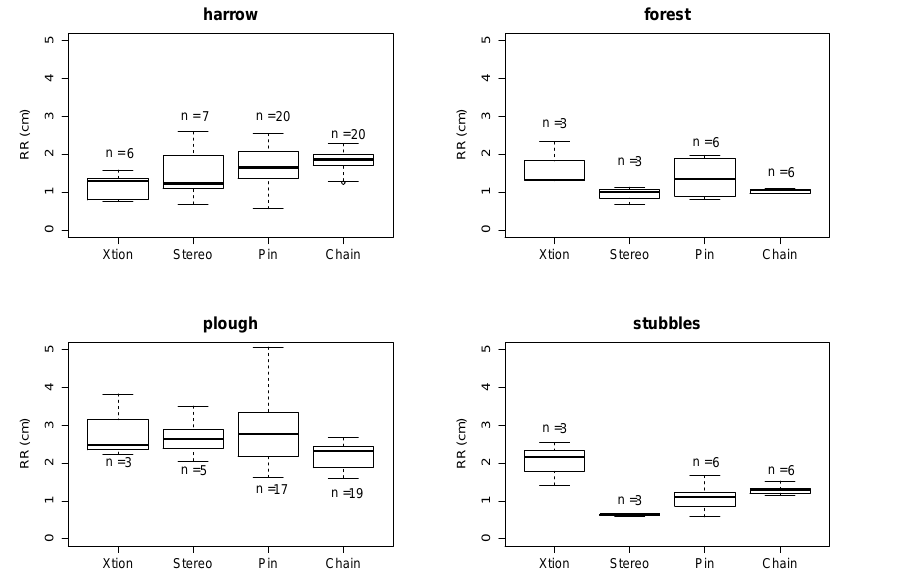
Figure 4. Box plot of RR values measured with four different methods on four different land units.